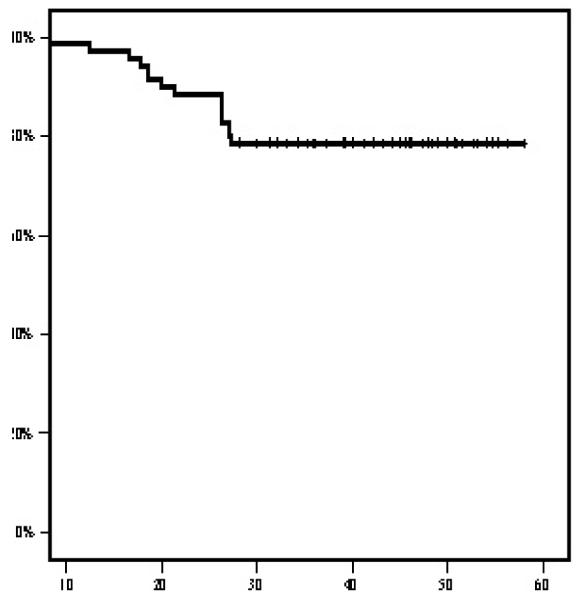
Disease free survival in months.